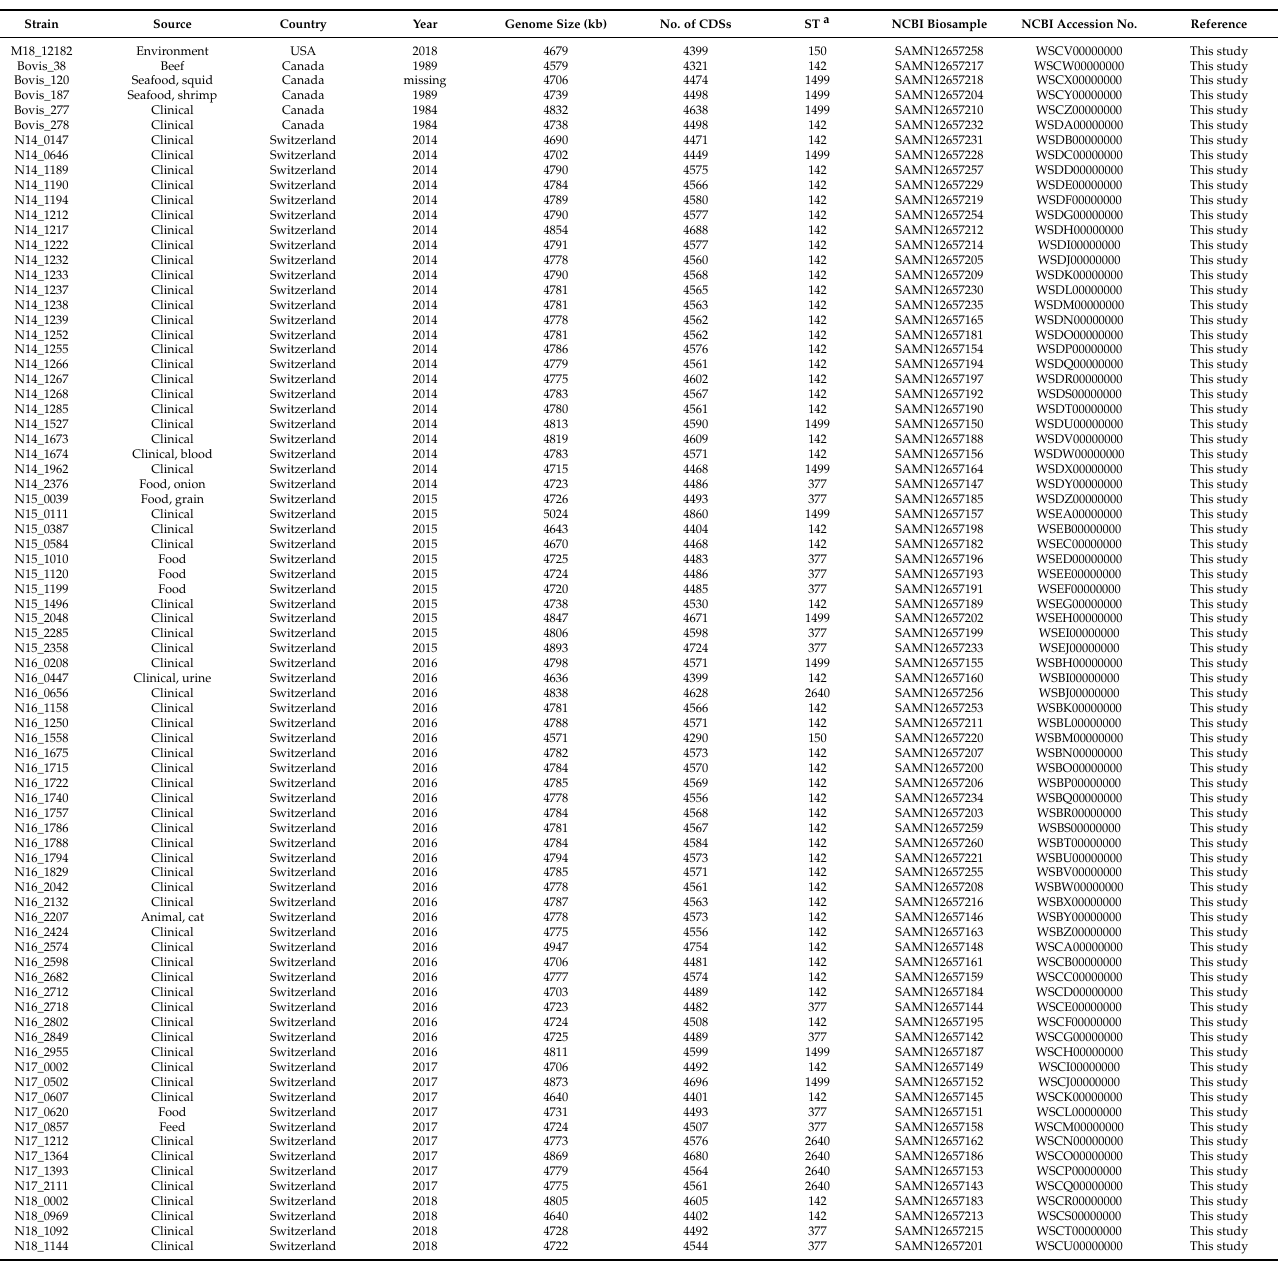
Table 1. Strain information (Strain name, Source, Country, Year of isolation, and Reference), genomic characterization (Genome size, No. of CDSs, and Sequence Type), NCBI Biosample, and GenBank accession numbers of 95 S. Bovismorbificans isolates used in this